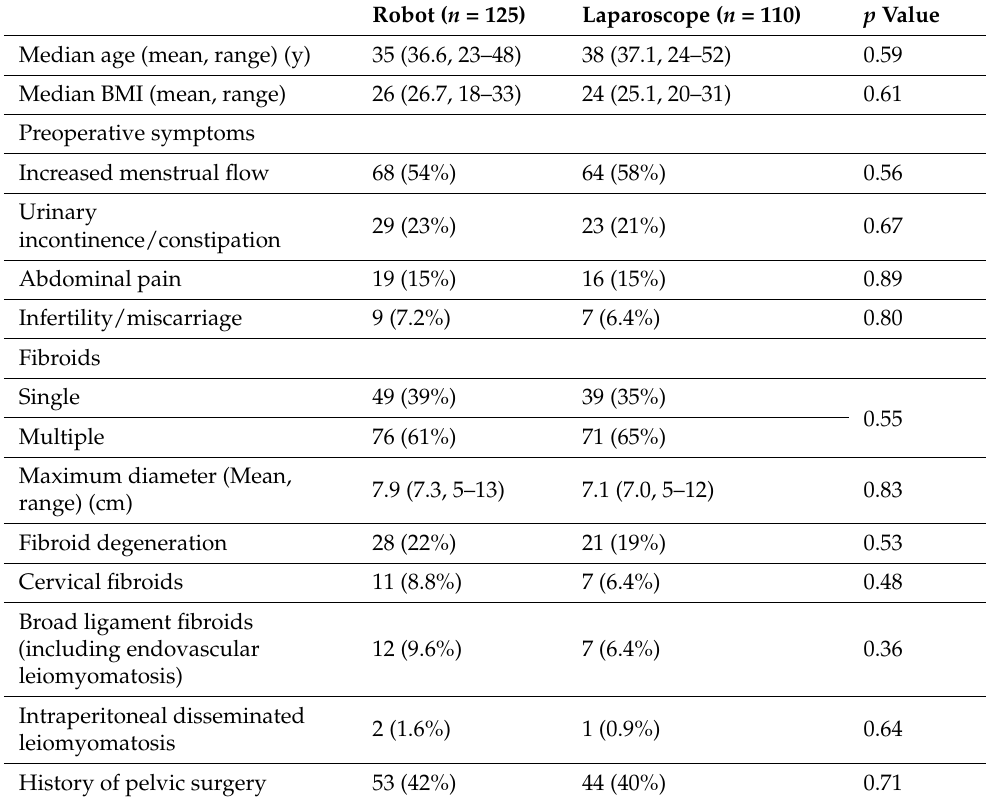
Table 1. Demographic